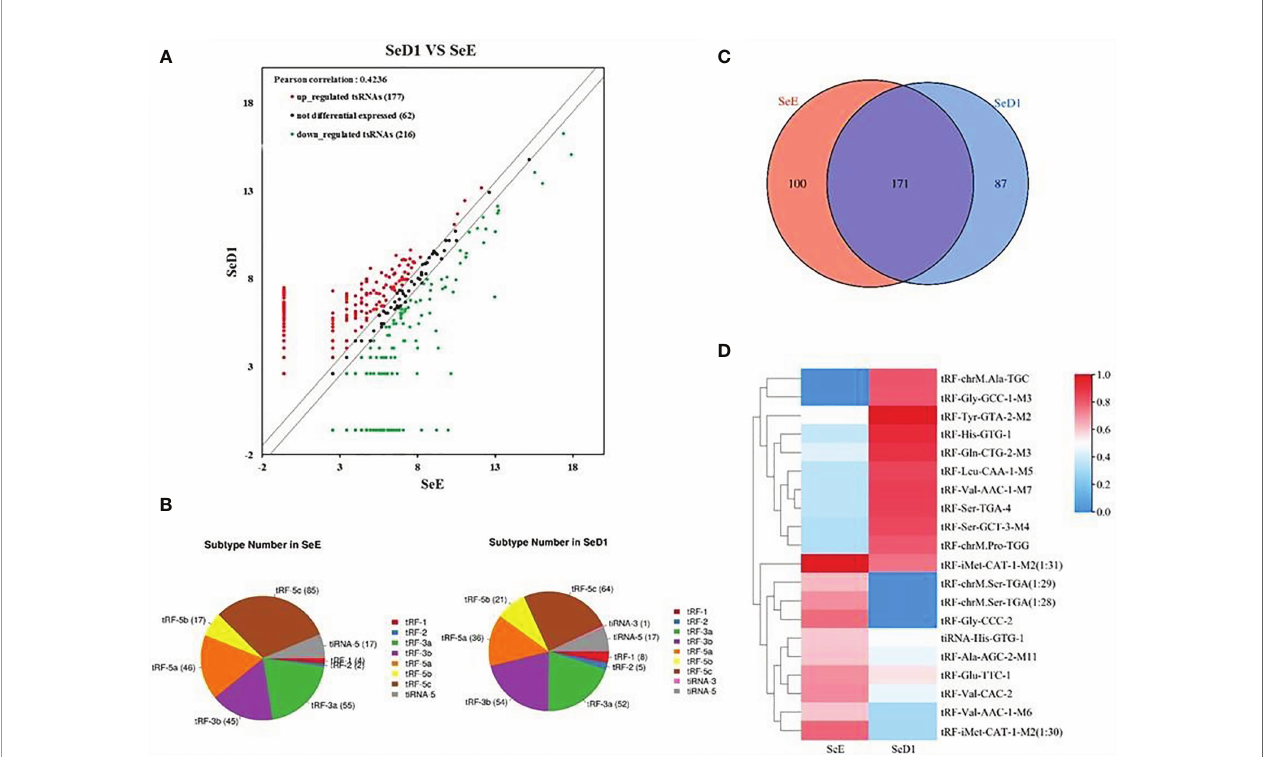
FIGURE 2 | Analysis of differentially expressed tsRNAs in serum of systemic lupus erythematosus (SLE) patients. (A) Scatter plots of differentially expressed tsRNAs. tsRNAs above the top line (red dots, upregulation) or below the bottom line (green dots, downregulation) indicate more than 1.5-fold change between the two compared groups. Gray dots indicate non-differentially expressed tsRNAs. Statistical correlation was determined by Pearson correlation. (B) Distribution characteristics of tsRNA in SLE patients and healthy controls. (C) Venn distribution of tsRNAs in SLE patients and healthy controls. (D) Hierarchical clustering indicates the differences in tsRNA expression pro fi ling between two